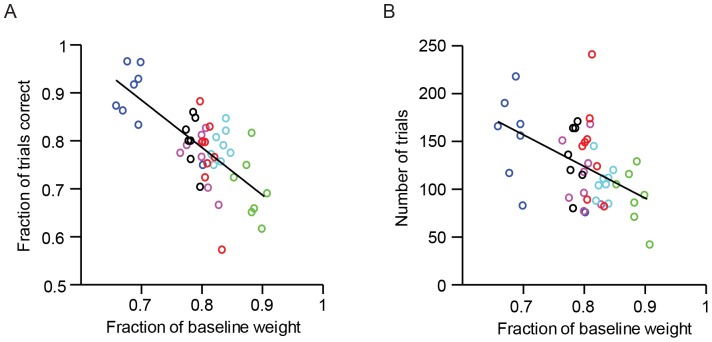
Performance as a function of normalized body weight.A. Performance as a function of normalized body weight. Each circle corresponds to one behavioral session. Different colors correspond to different mice (7–8 sessions per mouse). The sessions included are the first seven to eight sessions of discrimination training (corresponding to the training phase shown by open symbols in Figure 3a of [23]. Multiple factors can compromise performance in behavioral experiments. In this experiment mice were trained in serial with individualized attention to reduce variability due to uncontrolled factors. The correlation coefficient is R2 = 0.52 (p<0.001). B. Number of trials as a function of normalized body weight. Mice usually perform less trials in the first few sessions of training. Same sessions as in (A). The correlation coefficient is R2 = 0.24 (p<0.001).